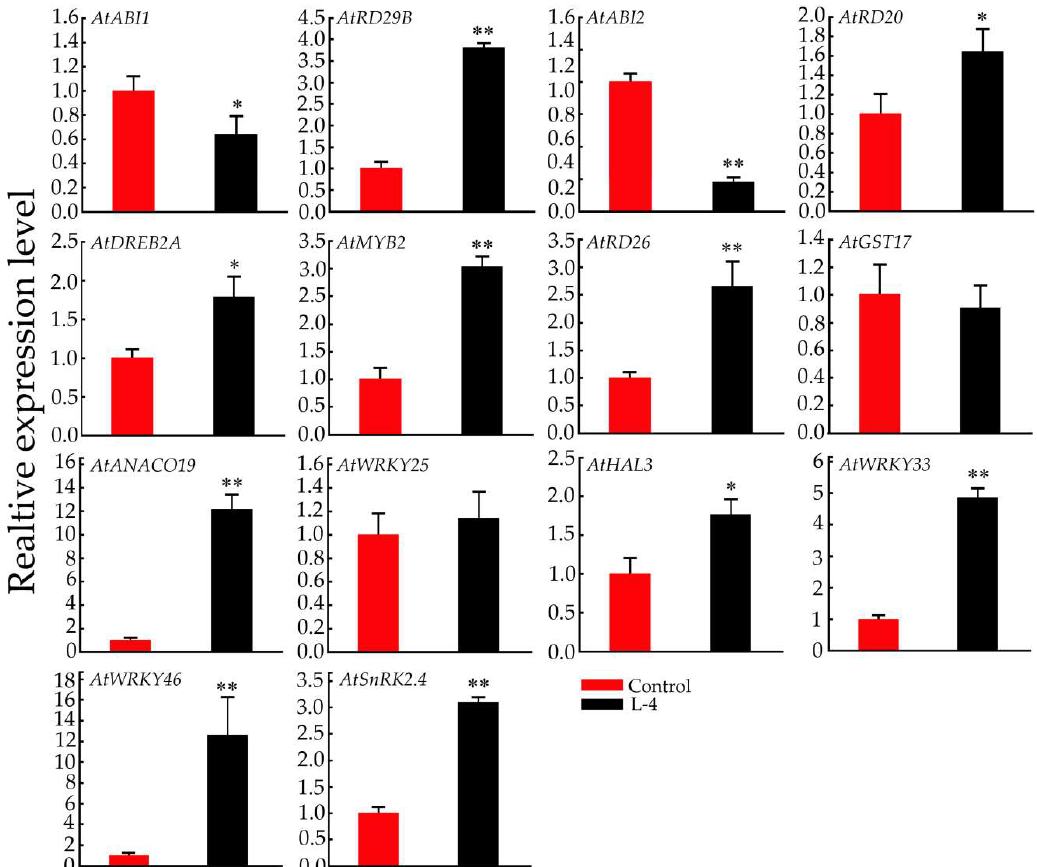
Figure 6. QPCR analysis of the expression levels of salt stress-related genes in the control (Col-0) and transgenic (L-4) Arabidopsis plants. Arabidopsis actin 1 ( AtActin1 ) was used as an internal standard to normalize the templates. The relative mRNA levels are represented as the mean ± SD ( n = 3). Statistically significant differences were assessed using Student’s t -test (* p < 0.05, ** p < 0.01).